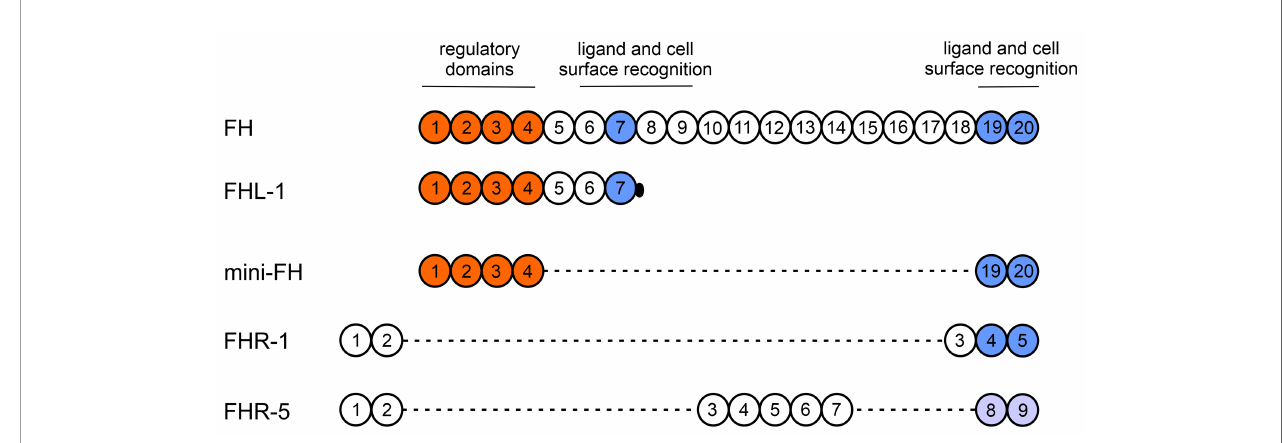
FIGURE 8 | Schematic structures of FH, FHL-1, mini-FH, FHR-1 and FHR-5. The individual SCR domains are indicated with numbered circles and are vertically aligned based on homology among the domains of the proteins. Major functional sites of FH are indicated above. SCRs marked orange are responsible for the complement regulatory functions, such as cofactor and decay accelerating activities and also binding to C3b. FH shows 100% amino acid sequence identity with the corresponding SCRs of FHL-1 and mini-FH, but FHL-1 includes a unique four aminoacid long sequence at its C terminus. SCRs marked blue are involved in binding to several ligands and cell surfaces and also have a role in receptor binding. A previous study using various FH fragments and receptor- speci fi c antibodies suggests that the FH C terminus mediates binding to CR3, whereas SCR7 to both CR3 and CR4 (15). Note that except for the C-terminal domains of FHR-1, FHR-1 and FHR-5 show lower aminoacid sequence similarity to the respective FH domains. The N-terminal domains of FHR-1 and FHR-5 mediate dimerization of these